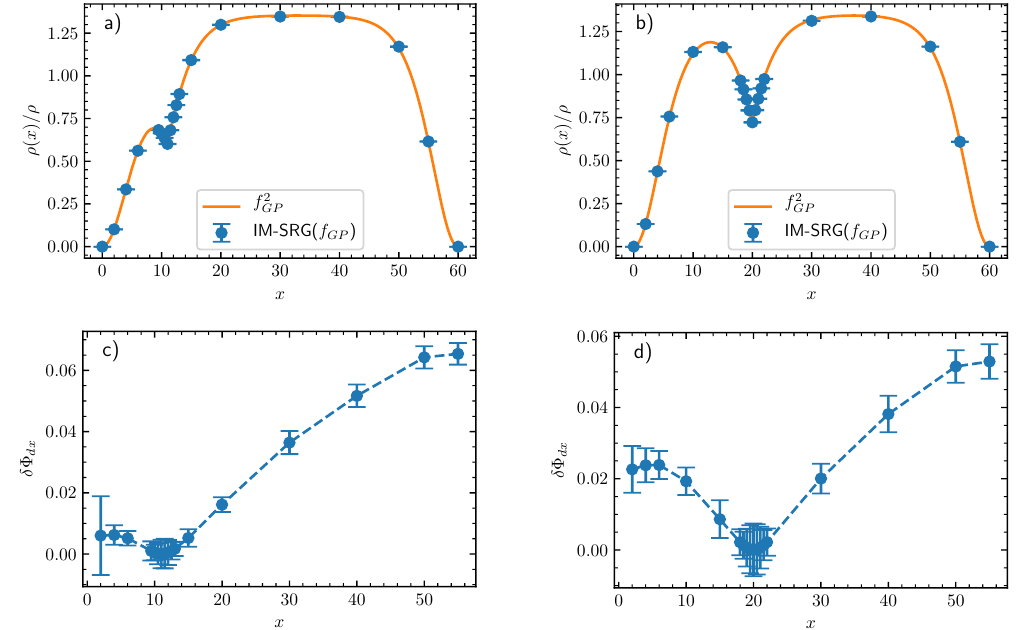
= 0.1 Figure 8: (Upper row): The density of the Bose gas for N = 60, γ = 0.02, c 2 and two values of the distance between the impurities: a) d = 11 and b) d = 20. Dots show the results of the IM-SRG( f ). For comparison, the solid curve gives the GP mean-field density. (Bottom row): Phase fluctuations of the Bose gas for N = 60, γ = 0.02, c = 0.1 and two values of the distance between the impurities: c) d = 11 2 and d) d = 20. The dots are calculated using the IM-SRG( f GP